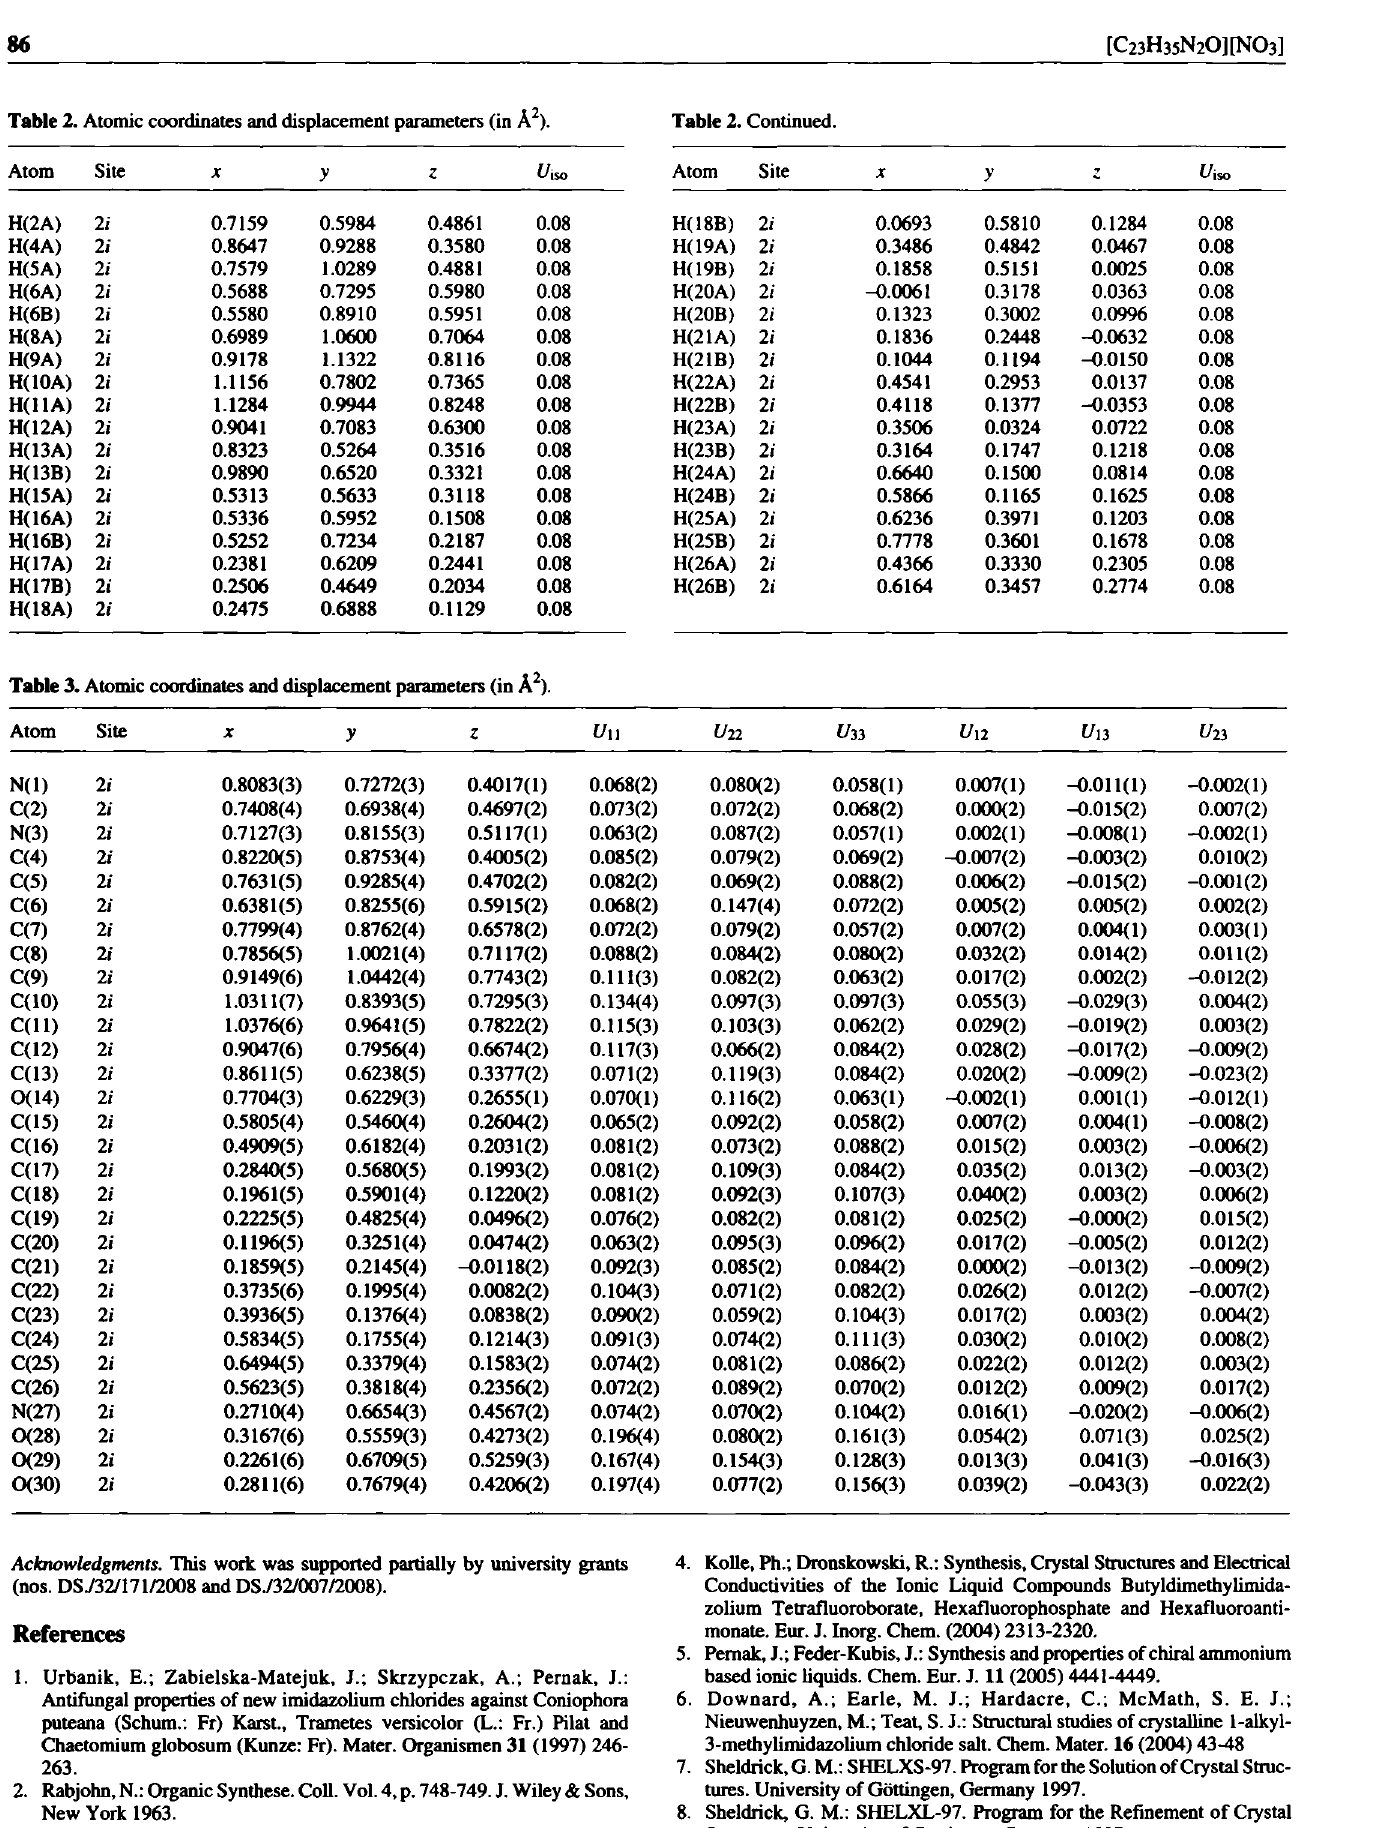
Table 3. Atomic coordinates and displacement parameters (in Â 2